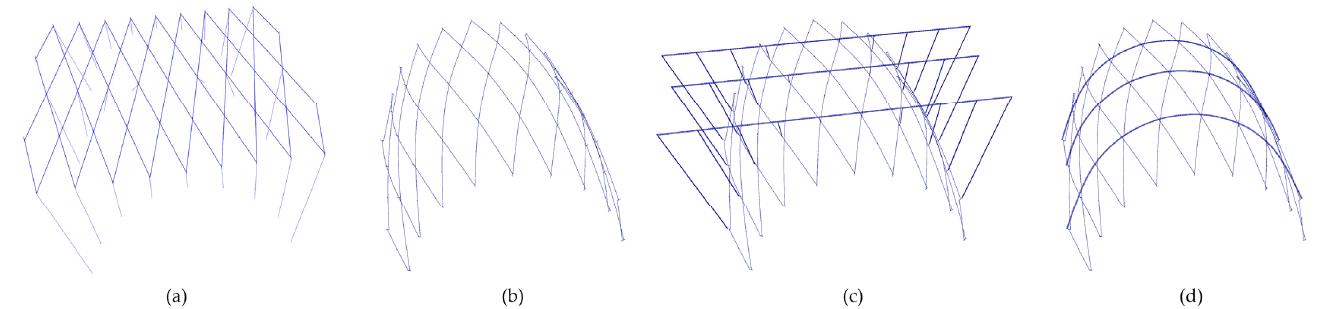
Figure 14. Simulation of the construction process of the TEL-gridshell lab prototype: ( a ) and ( b ) grid bending; ( c ) and ( d ) bending of transverse laths.